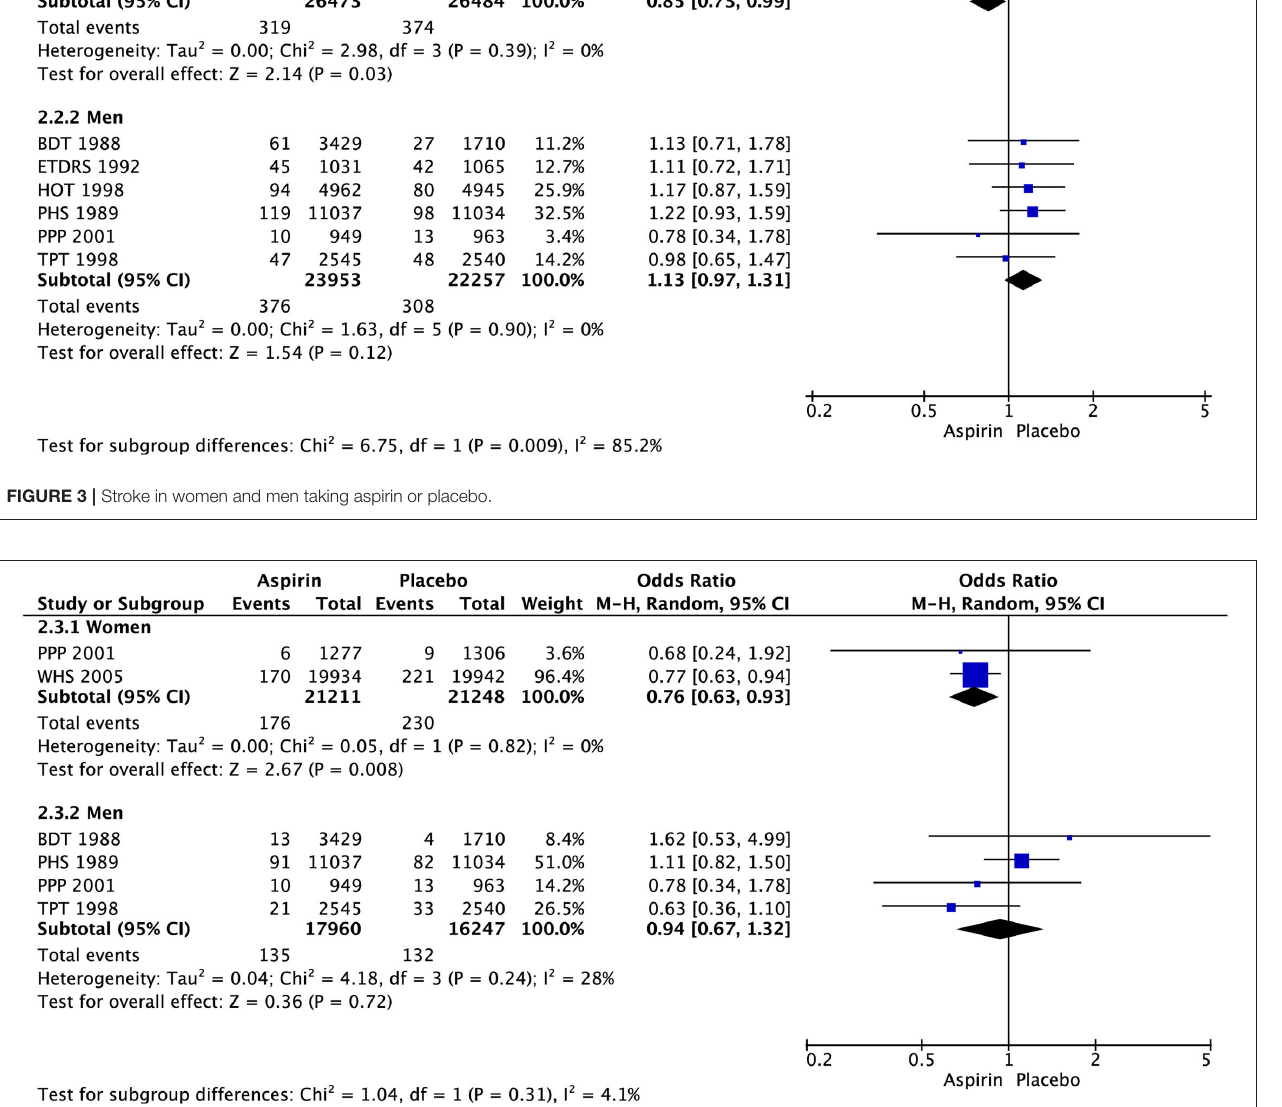
248 patients from 7 RCTs ( Figure 10 ) ( Table 3 ) were significantly lower in women compared to men ( Table 3 ). On meta-analyzing the Hazard ratio, there was no marked effect of aspirin on composite outcome compared to placebo in women HR